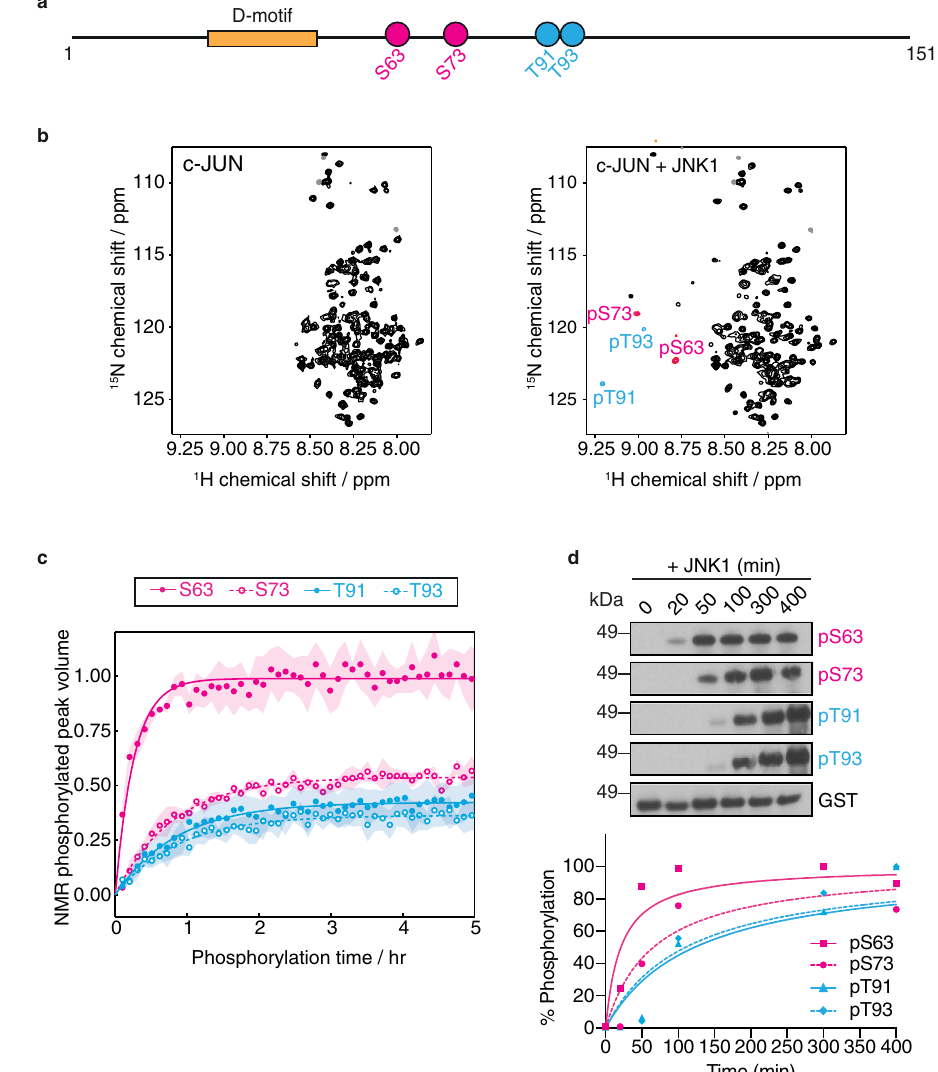
Fig.1|Multisitephosphorylationkineticsofthec-JUNTADbyJNK1.a Schematic representation of the c-JUN TAD sequence, showing the location of the fast (pink) and slow (cyan) S/T-P phosphorylation sites and the JNK binding motif (D-motif) (yellow). b 2D 1 H, 15 N correlation spectraof(left) unphosphorylatedc-JUN TAD,and (right) following 5h in vitro phosphorylation by JNK1. Resonances from phos- phorylated residues are highlighted with pink or cyan colouring corresponding to fastorslowsitesrespectively,withassignmentsasindicated. c Site-speci fi ckinetics of c-JUN phosphorylation by JNK1 obtained from time-resolved NMR measure- ments, showing fi ts to single exponential build-ups. Data are plotted as the